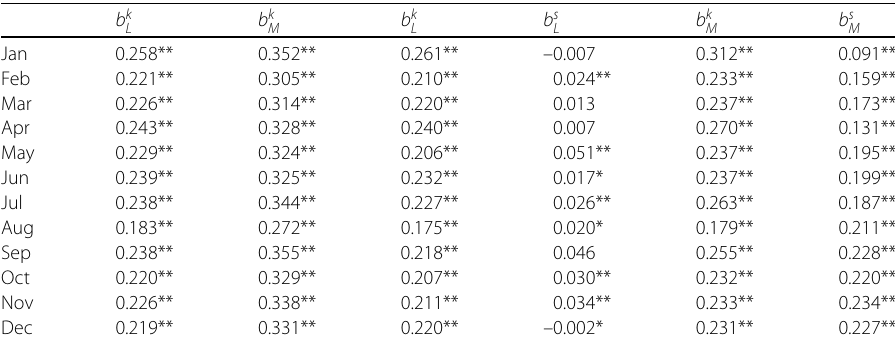
Table 9 Coefficients for multinomial logistic regression of out-degree distribution. The first two columns refer to the regression with the degree as only predictor. The last four columns refer to the regression with also the size as predictor. The superscript indicates the predictors: k for the degree, s for the size. The subscript indicates the risk rating. The stars indicate significance: one star if the p-value < 0.05, two stars if the p-value < 0.01 b k L Jan